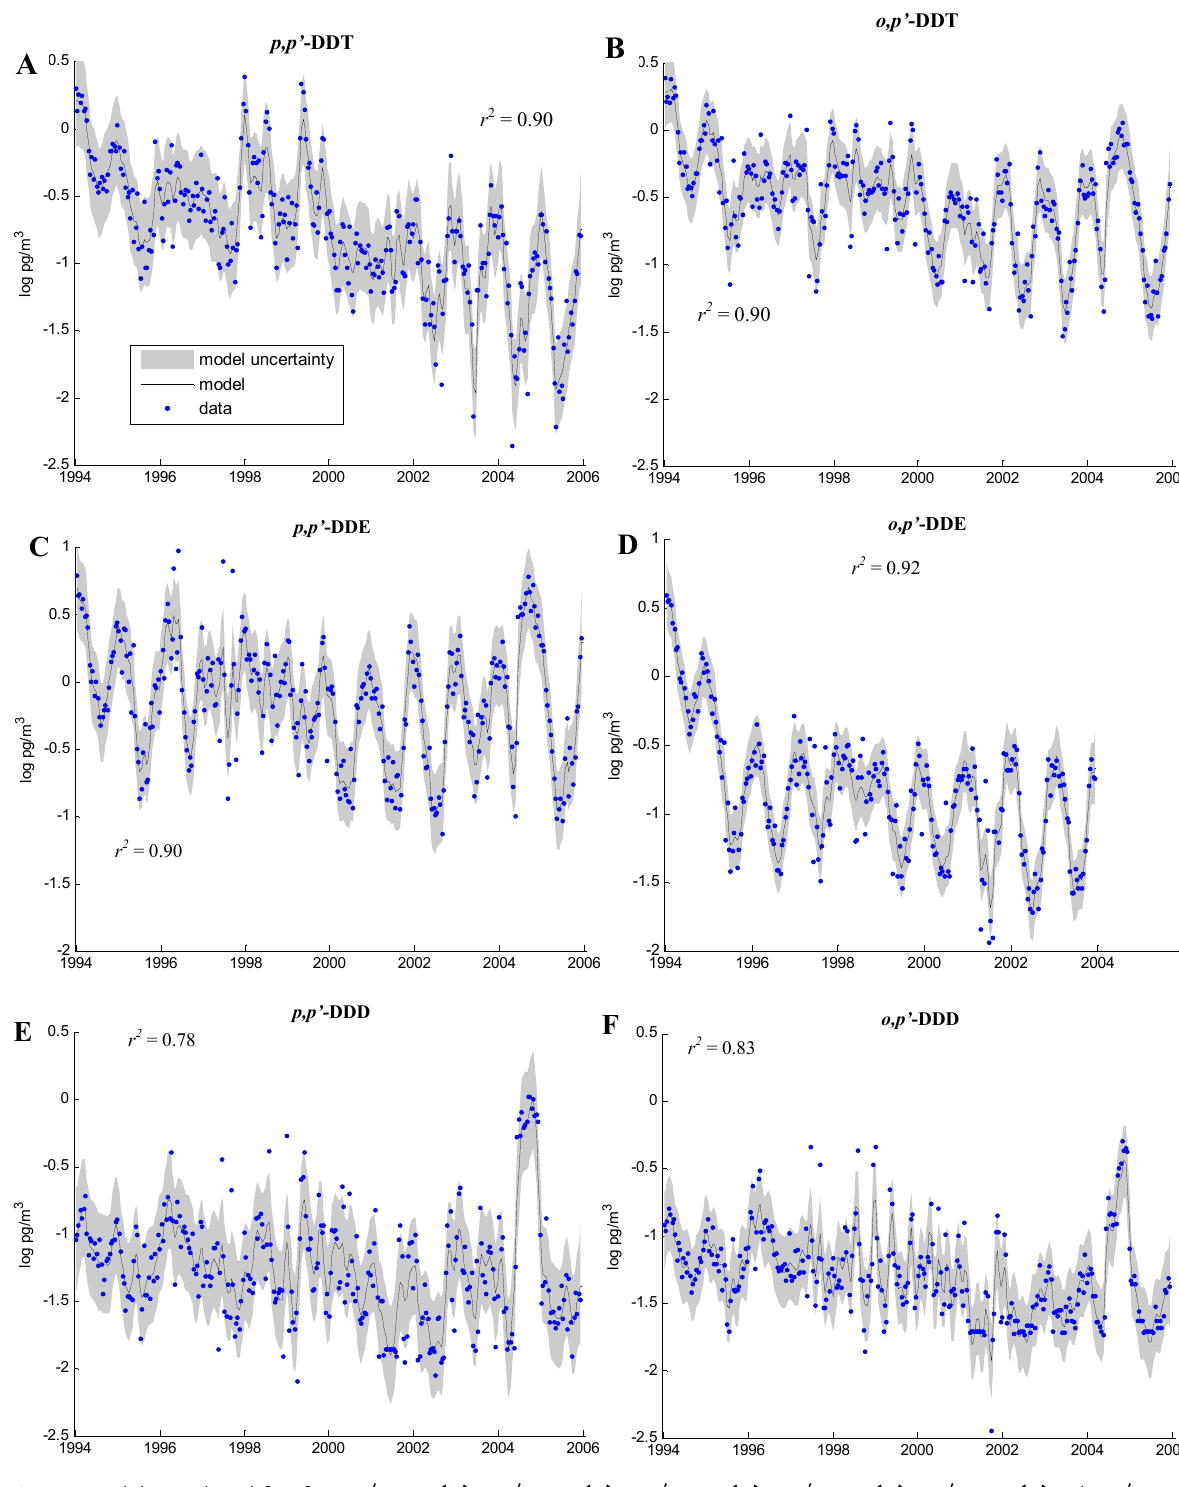
by the r 2 value ( p <0.05).